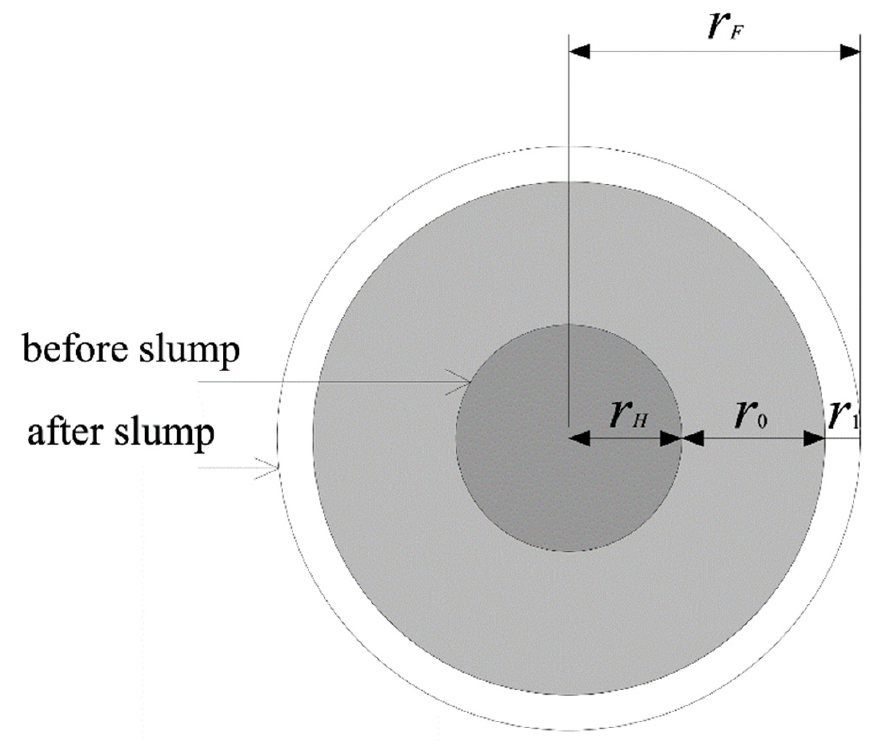
Figure 6. Diagram of mixture slump flow. Next, r 0 can be expressed as Equation (20).